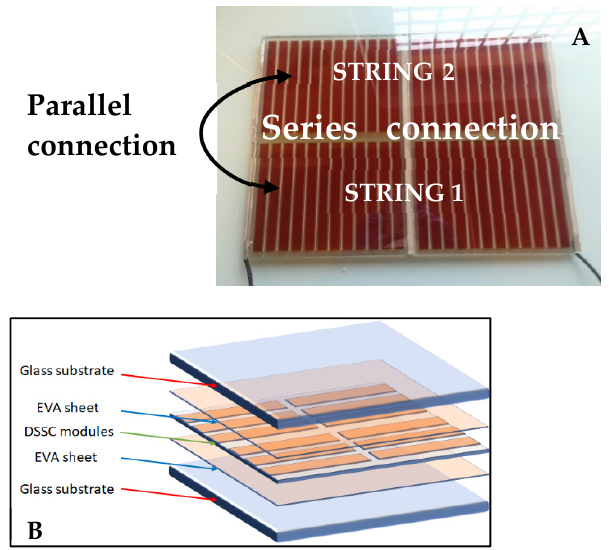
Figure 4. Two serially connected DSSC strings, set in parallel to form a 4 × 4 DSSC panel ( A ); DSSC panel structure ( b ).